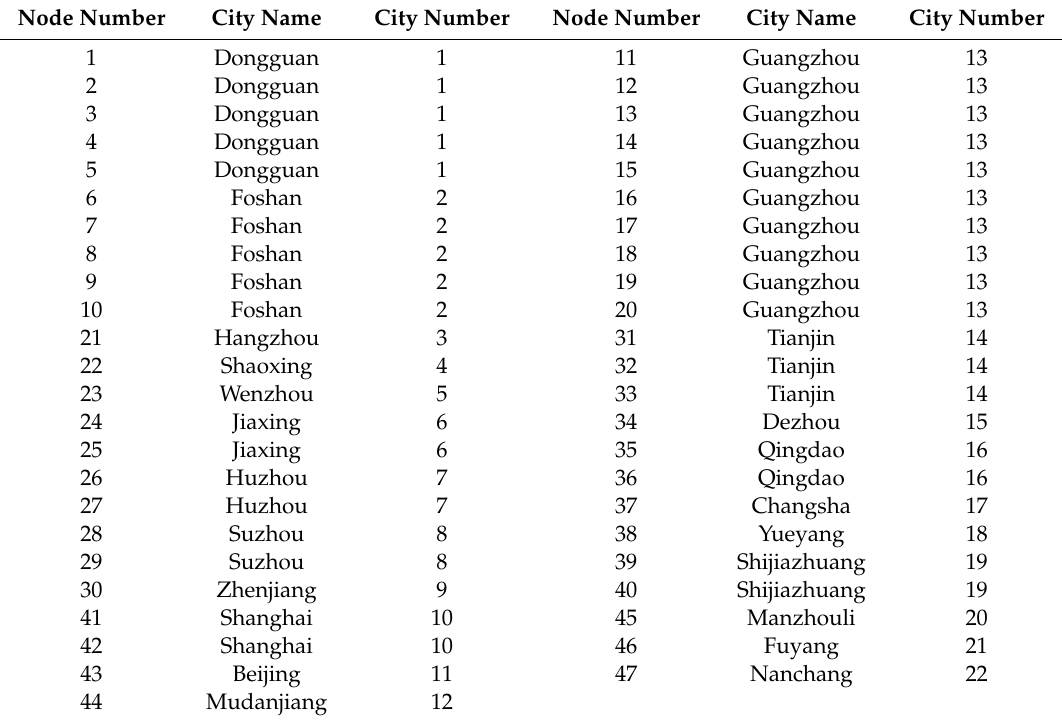
Table 12. Correspondence between city number and node number.